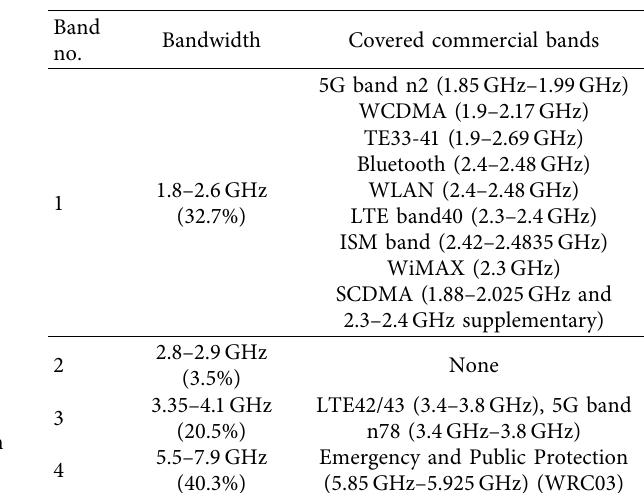
Table 3: The frequency bands covered by the proposed